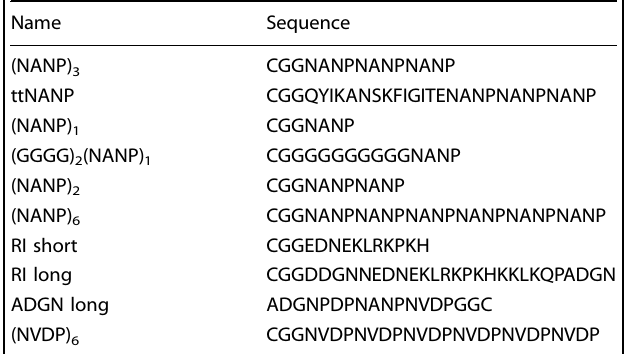
Table 1. Peptides coupled to Q β